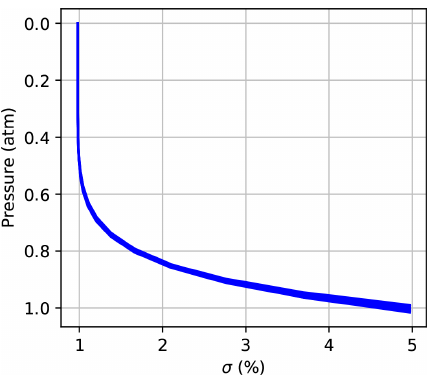
Figure 3. A priori uncertainty profiles for each of the 10 dates pre- sented in Table 3. These are defined by Eq. (1). Since σ is defined on an altitude grid, it varies slightly with